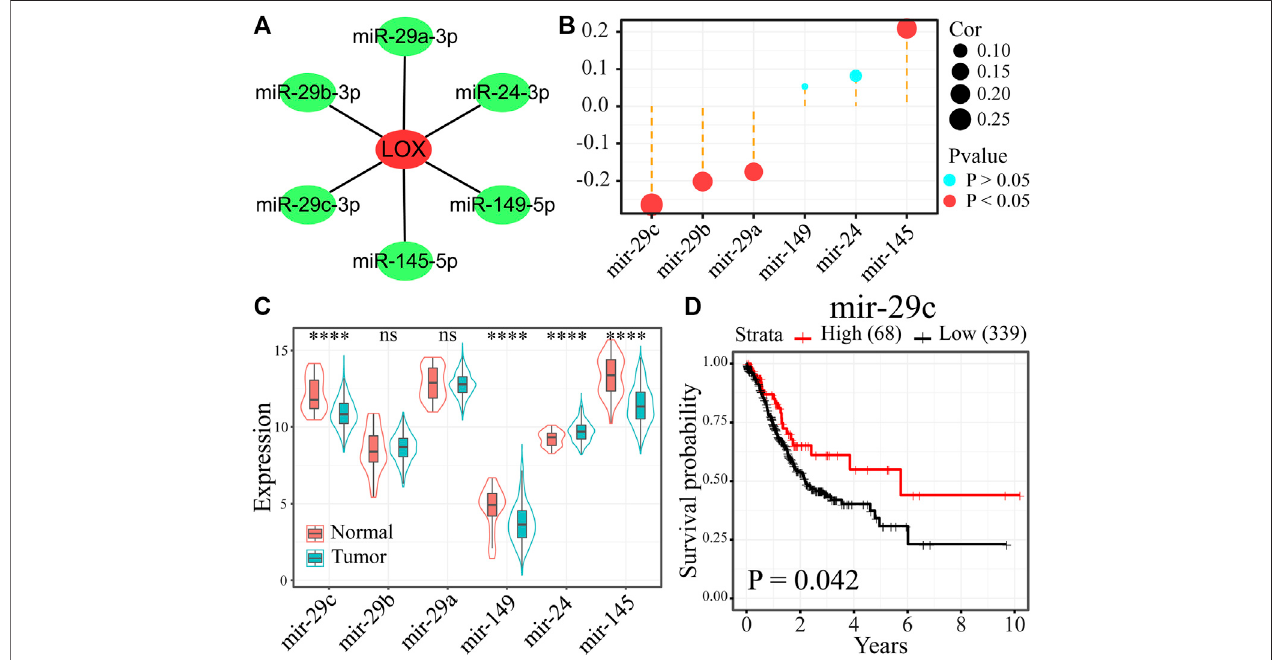
FIGURE 3 | miRNA-29c might be the most probable upstream regulatory miRNA of LOX in gastric cancer. (A) Six potential upstream miRNA candidates of LOX werepresented using Cytoscapesoftware. (B) The relevance analysisbetween sixmiRNAs and LOXexpression values in 372 STAD samples. (C) The expression ofsix miRNAs in 436 STAD samples and 41 non-cancer samples. (D) The survival curves of miRNA-29c in STAD patients (Kaplan – Meier plotter). **** p < 0.0001.